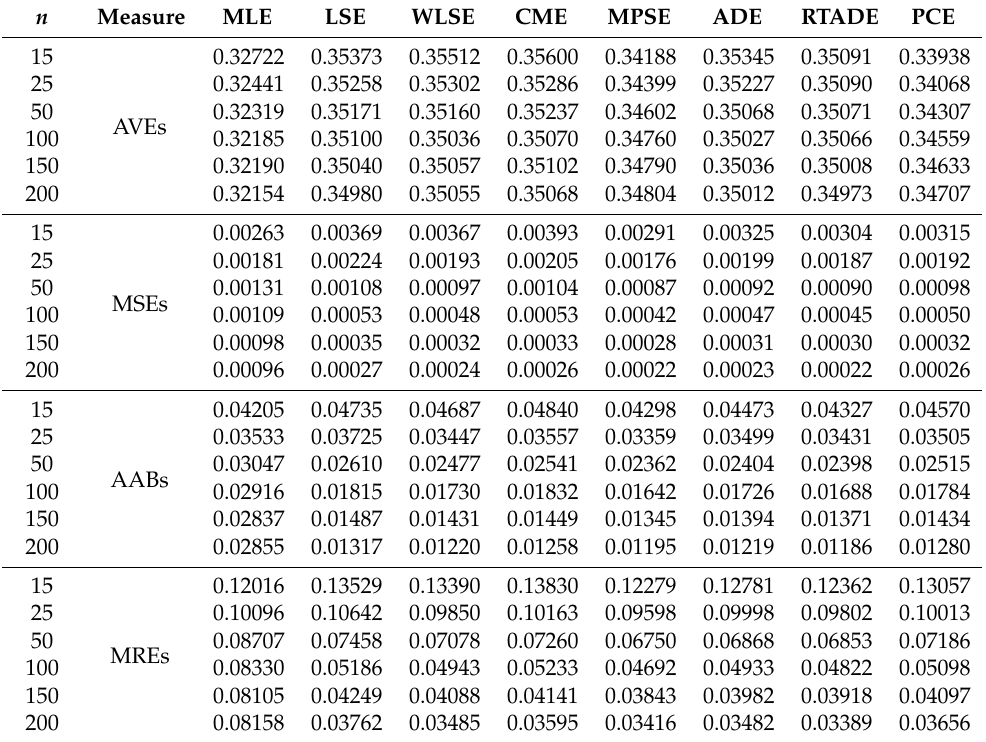
Table 3. Simulation results for the NDL distribution for θ = 0.35.